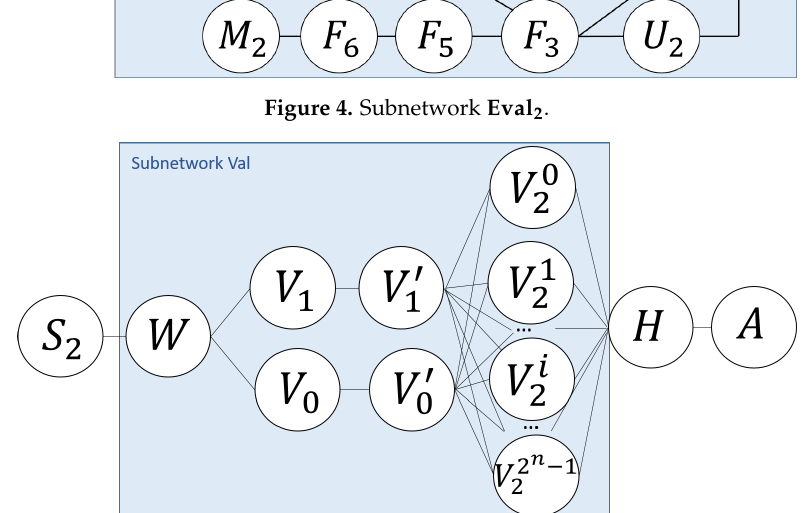
Figure 4. Subnetwork Eval 2 .